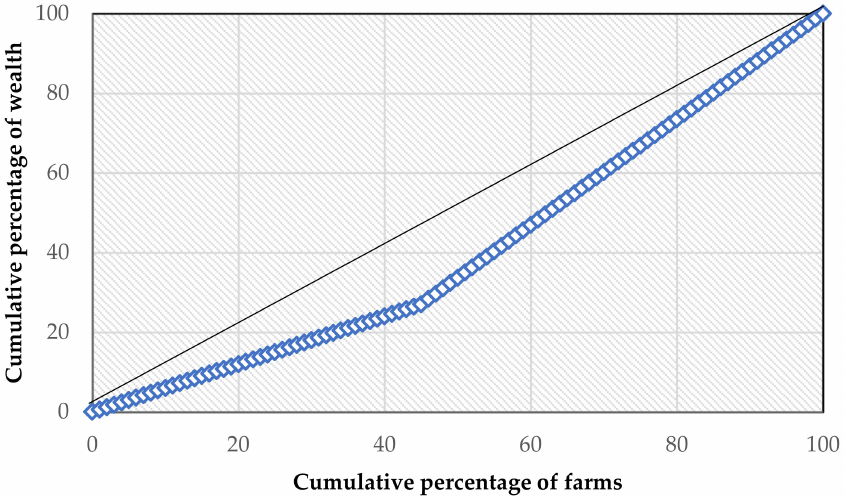
Figure 4. Lorenz curve for the current situation. Source: Own elaboration based on model results (2022).